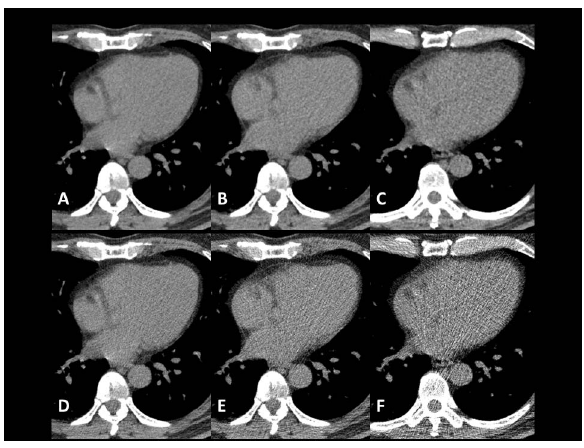
Figure 5. Axial plain chest CT images with a mediastinal setting to assess streak artifacts (55-year-old male weighing 64 kg). A , at 240 mA with AIDR3D; B , at 120 mA with AIDR3D; C , at 60 mA with AIDR3D; D , at 240 mA without AIDR3D; E , at 120 mA without AIDR3D; F , at 60 mA without AIDR3D. Many radial streaks from the spine were apparent in the heart, particularly on the image without AIDR3D at 60 mA ( F ). These streaks were greatly reduced using AIDR3D ( C , at 60 mA).